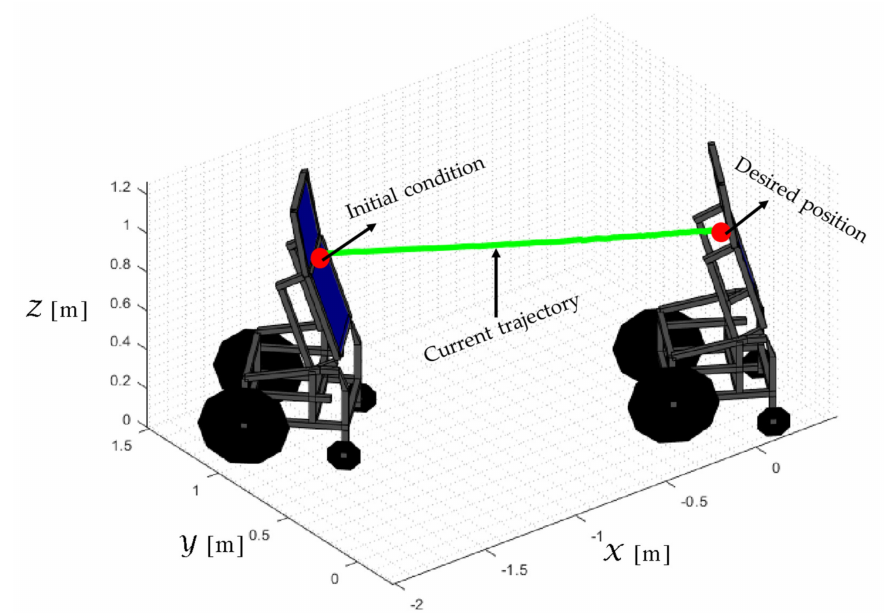
Figure 12. Stroboscopic movement of the human–robot system based on the real experimental data.